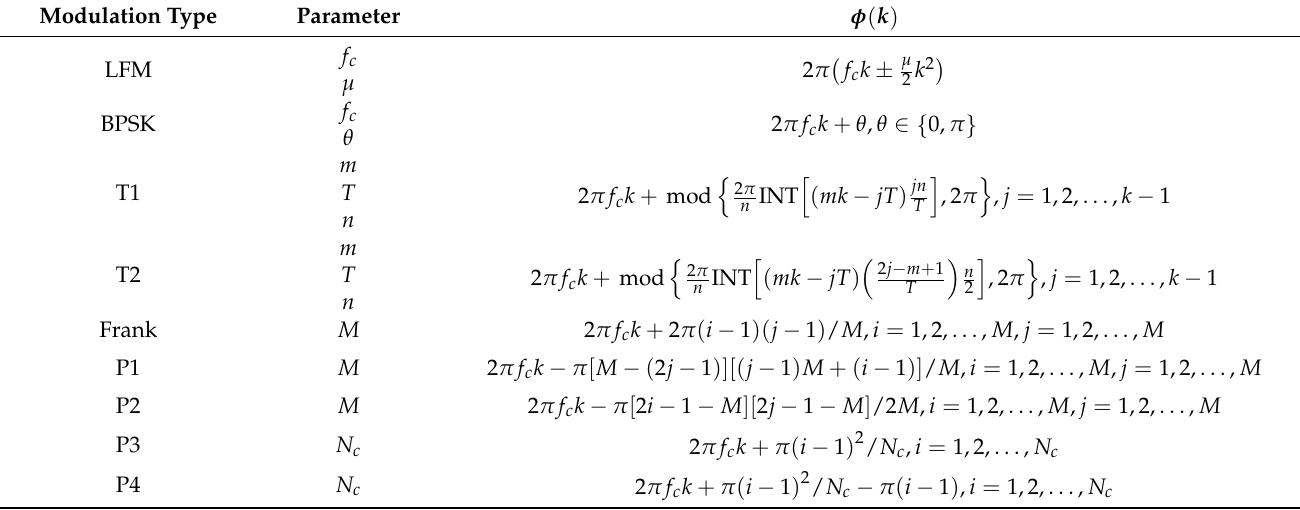
Table 1. The instantaneous phase representation of nine types of radar